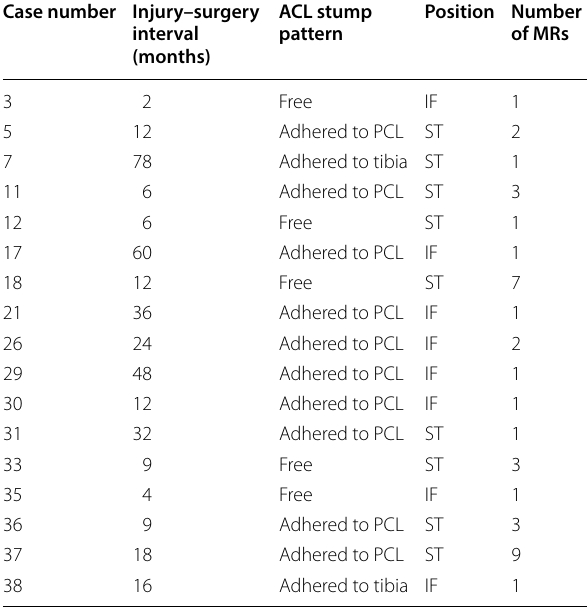
Table 1 Frequency, morphology, and location of mecha- noreceptors in tibial remnant of